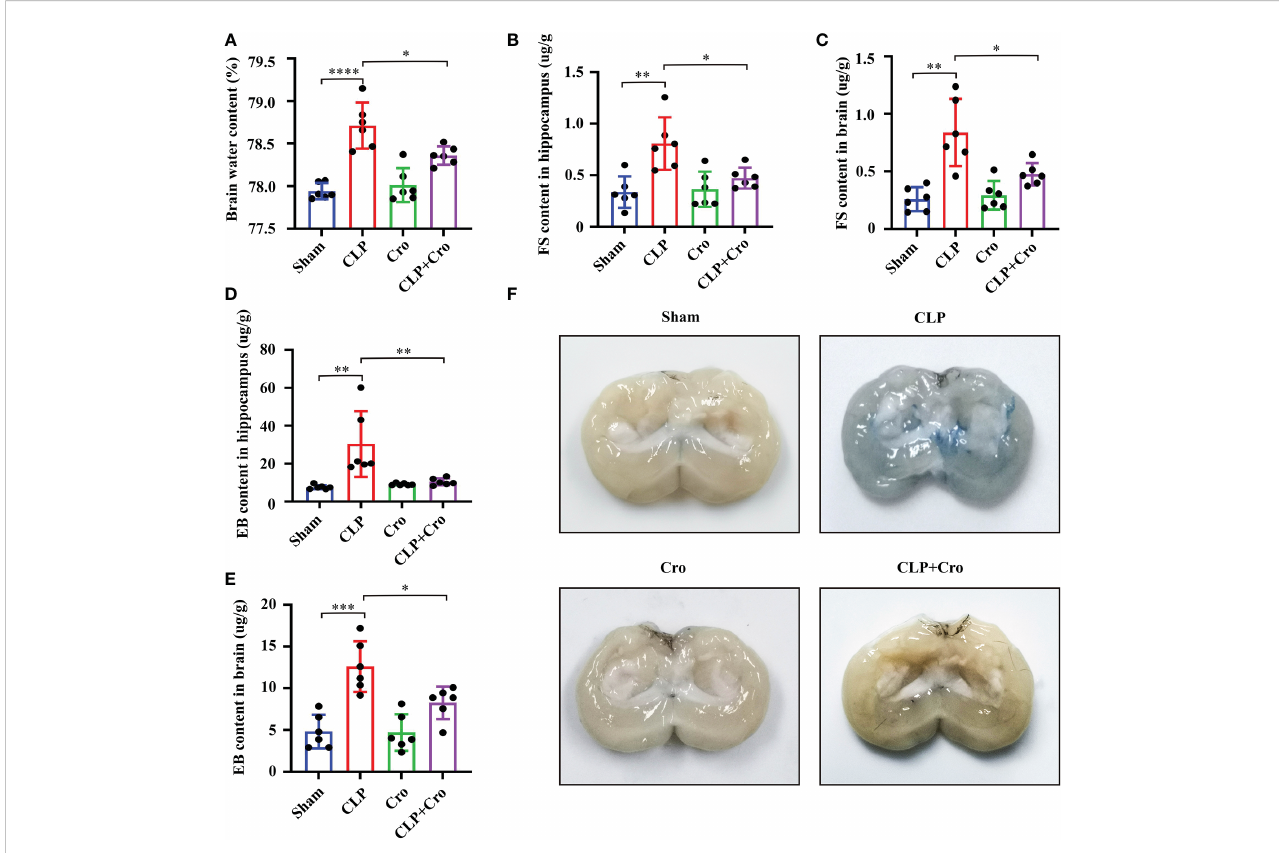
FIGURE 3 Cromolyn reduced BBB permeability in septic mice by inhibiting MC activation. (A) The brain water content was measured. Quanti fi cation of the Fluorescein sodium extravasation in the hippocampus (B) and the global brain tissue (C) Evans blue extravasation in the hippocampus (D) and the global brain of mice (E) was also detected (n=6). (F) The representative images of Evans blue staining of the brains (n=6). MCs, Mast cells; CLP, Cecal Ligation and Puncture; SAE, Sepsis-associated encephalopathy, BBB; Blood – brain barrier, (* p <0.05, ** p <0.01, *** p <0.001, **** p